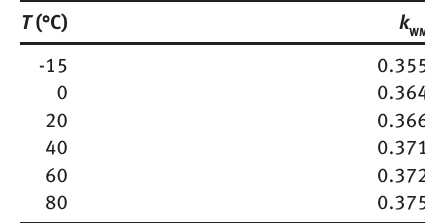
Table 5 Estimated thermal conductivity of